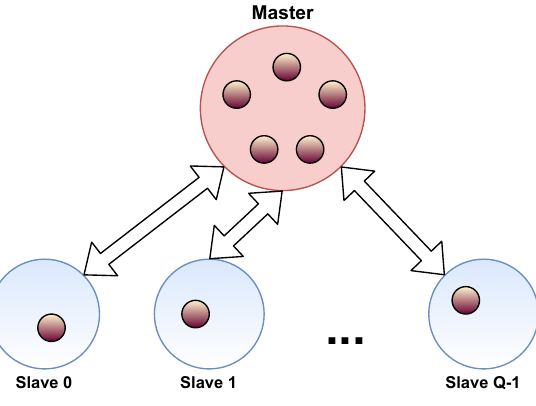
Figure 1. Master-slave model for distributed genetic algorithms. The top light-brown circle represents the master node, the light-blue nodes the slave nodes, and the small brown nodes the individuals. In this architecture, individuals can move only from a slave to a master and